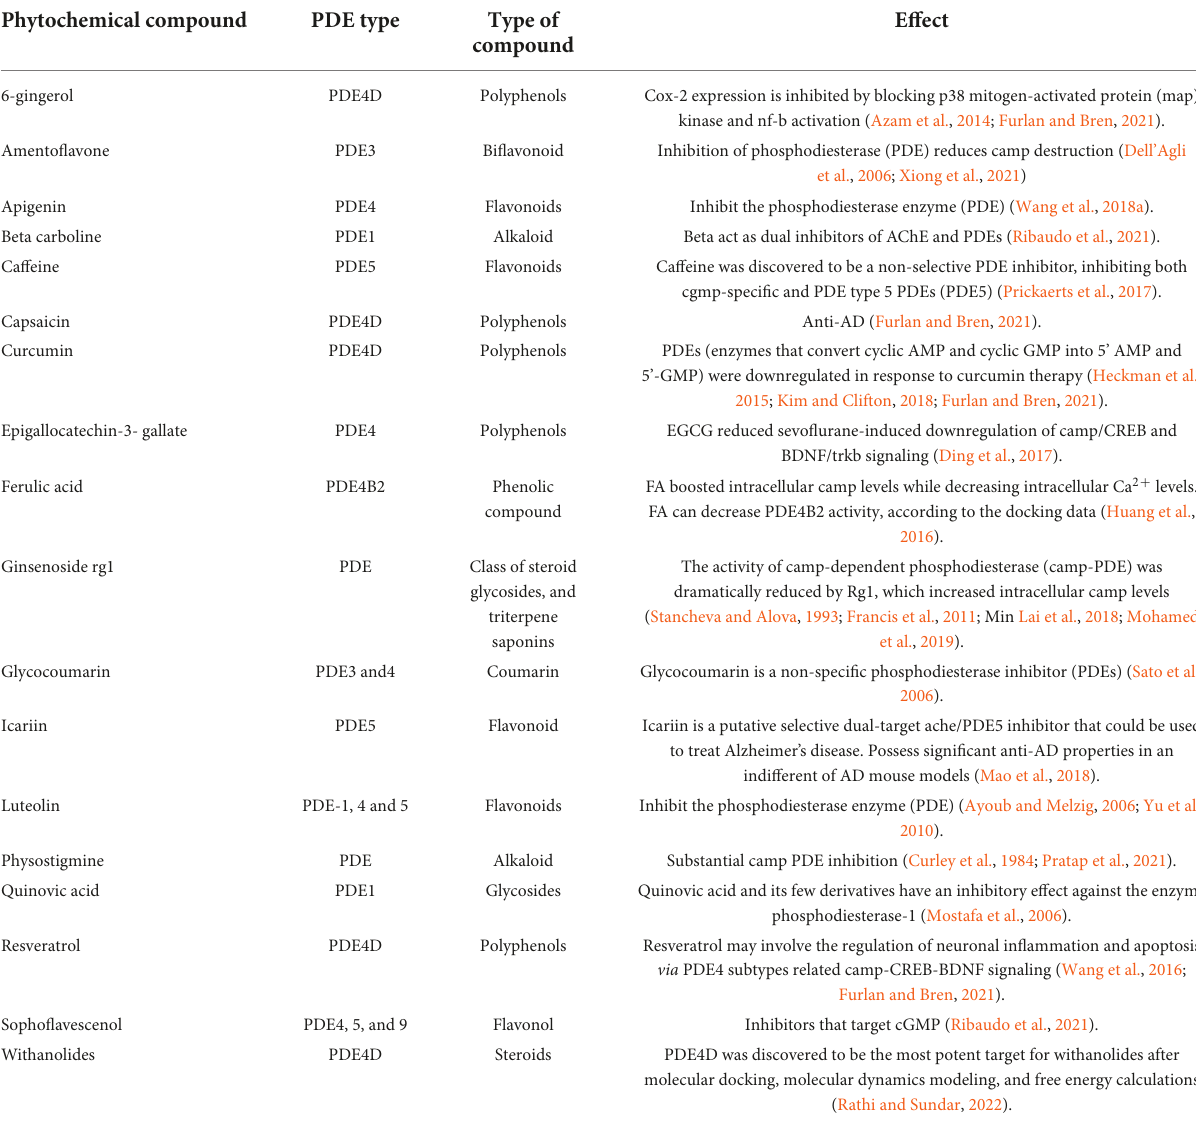
TABLE 3 List of natural products for PDE inhibitors and their impact on cognitive enhancement in clinical research, with a focus on Alzheimer’s